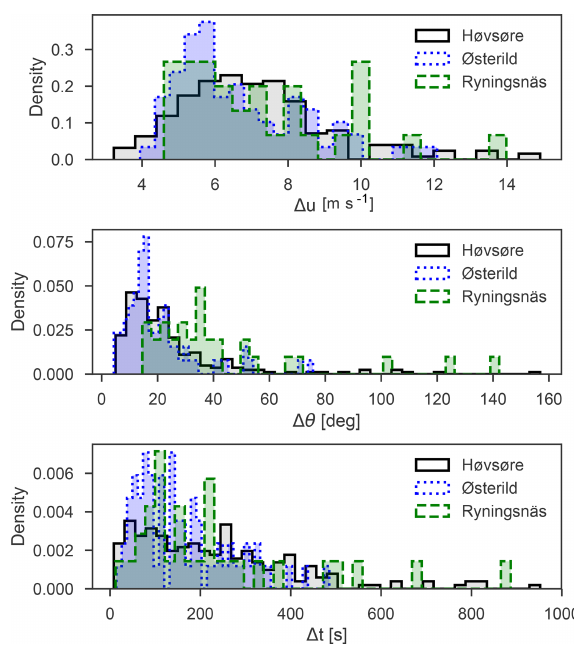
Figure 7. The distributions of detected amplitudes ( (cid:49)u ), direc- tion changes ( (cid:49)θ ), and rise times ( (cid:49)t ) of all the detected events at the three different sites: Høvsøre (grey), Østerild (blue), and Ryn- ingsnäs